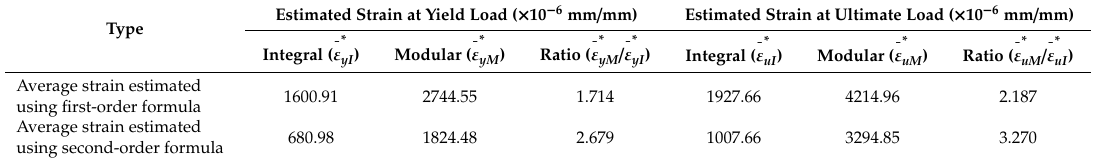
Table 7. Comparison of the estimated strains for the integral and modular